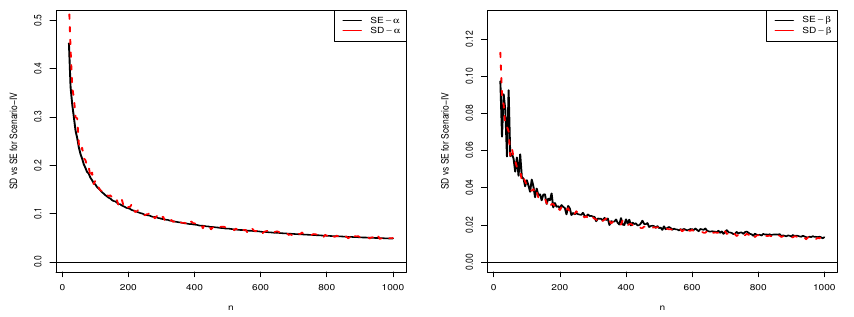
Figure 15. Comparison of SD and SE for the